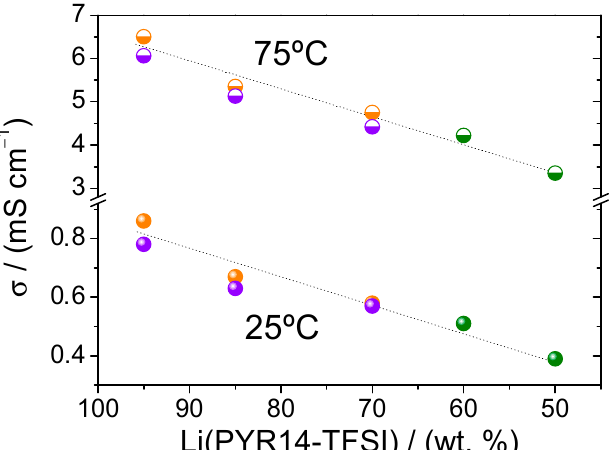
Figure 4. σ as a function of the concentration of liquid electrolyte Li(PYR14-TFSI) in the gels at 25 and 75 °C. Orange for manually mixed samples, violet for extruded samples, and green for the electrolytes with TPGS-S.